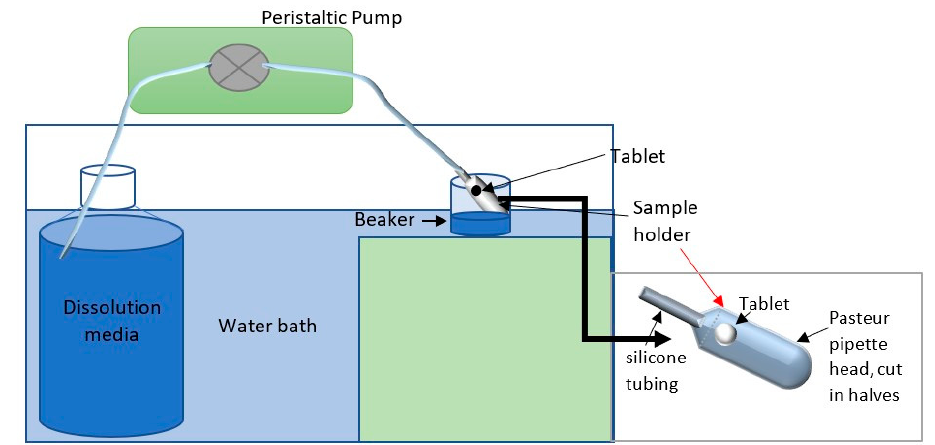
Figure 6. Diagram illustrating the setup of the CFR method.